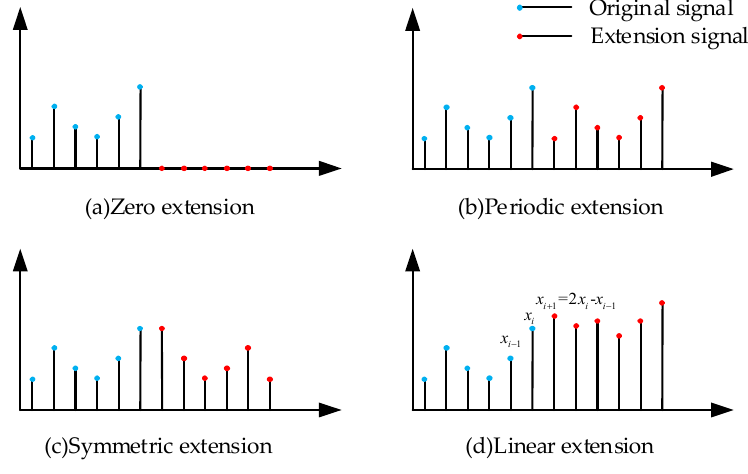
Figure 3. Common boundary extension methods.